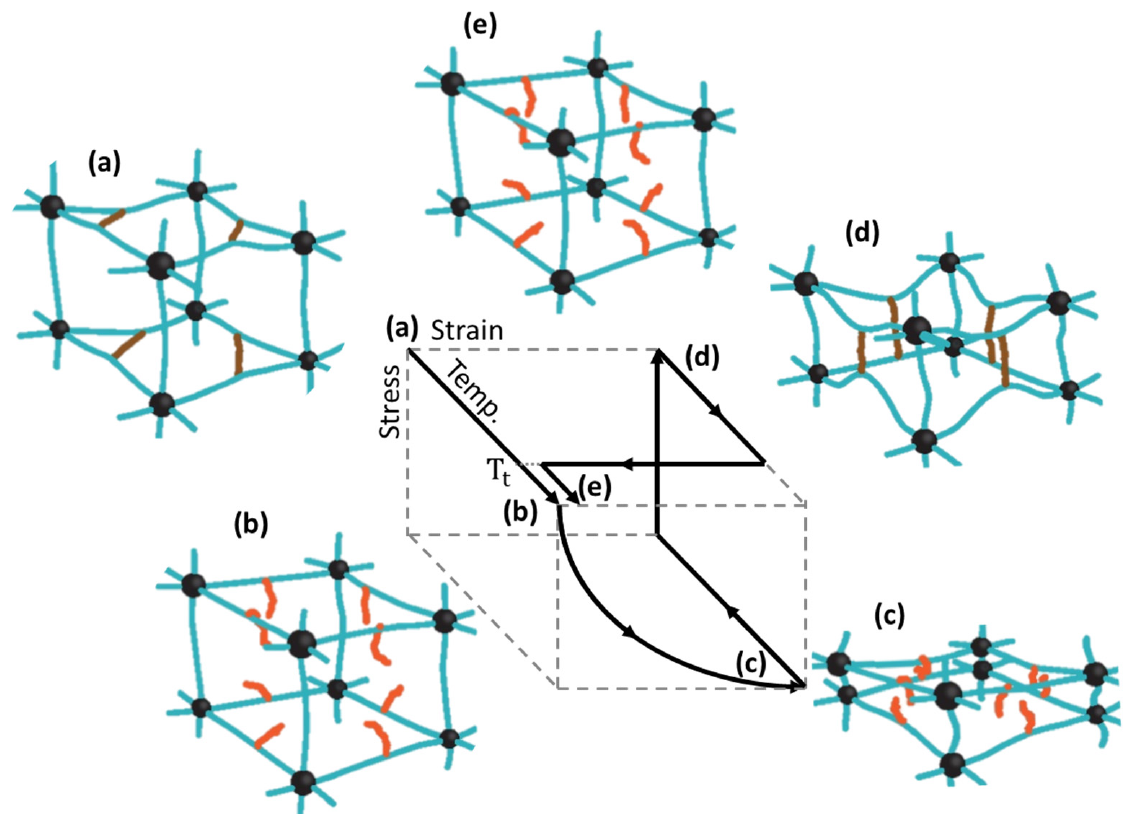
Figure 1. Schematic representation of programming process for thermo-responsive shape memory polymer with schematic of thermomechanical cyclic. Black dots and blue lines: hard segment; brown lines: soft segment below T t ; orange lines: soft segment above T t . ( a ) Initial shape; ( b ) shape at the elevated temperature ( c ) shape mechanically deformed at the elevated temperature; ( d ) shape fixed as deformed by cooling; and ( e ) shape recovered by heating.